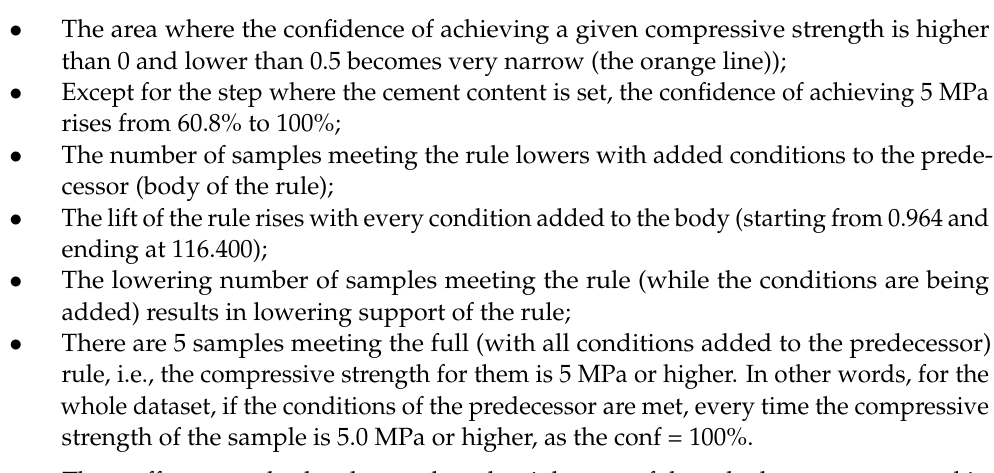
Figure 15. Areas of different certainty of achieving certain compressive